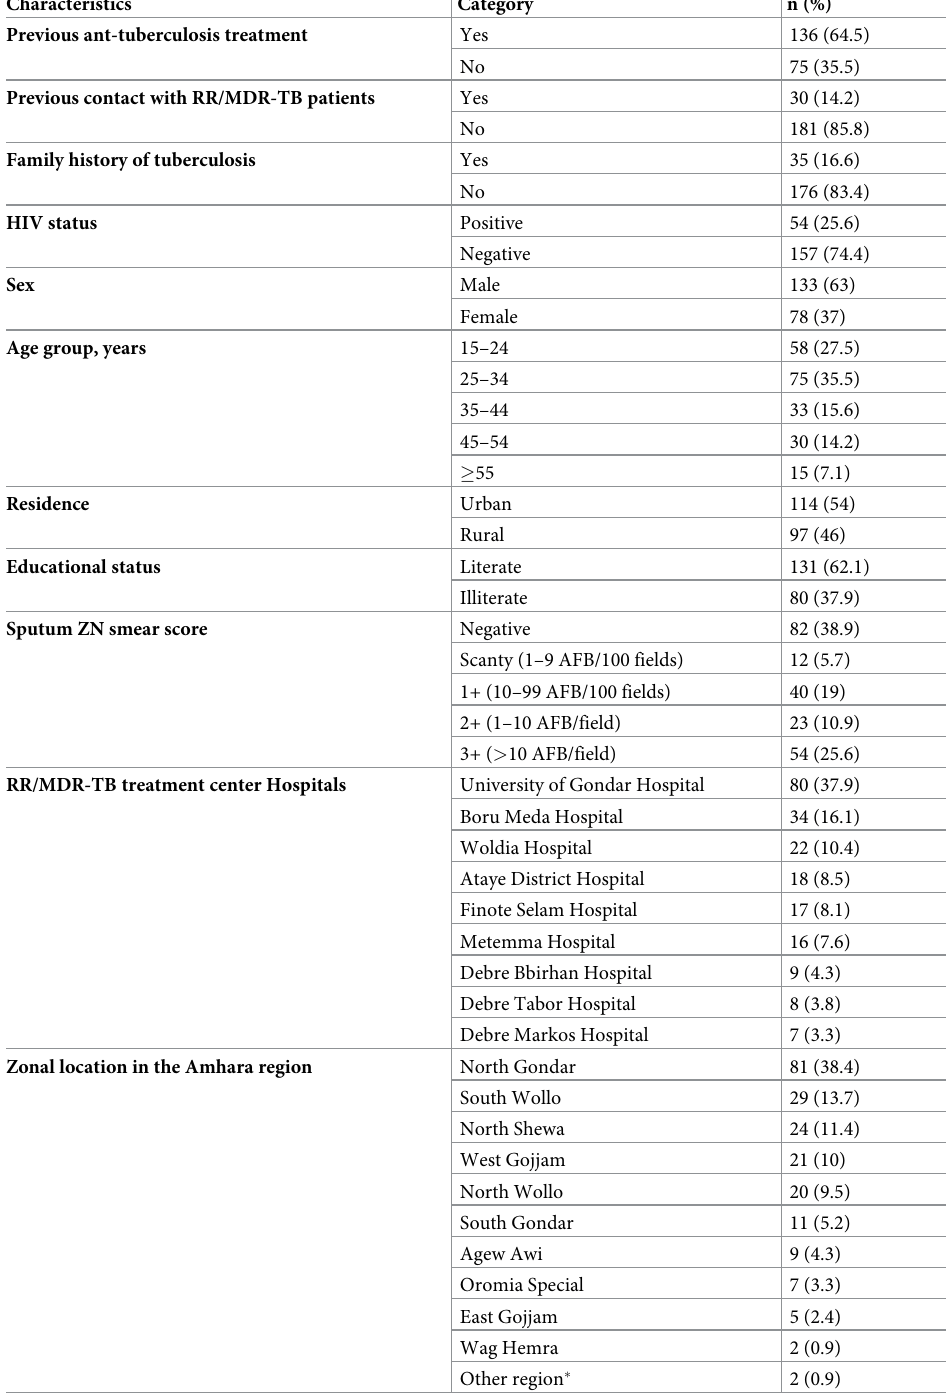
Table 1. Demographic and clinical characteristics of study participants in the Amhara region (N =